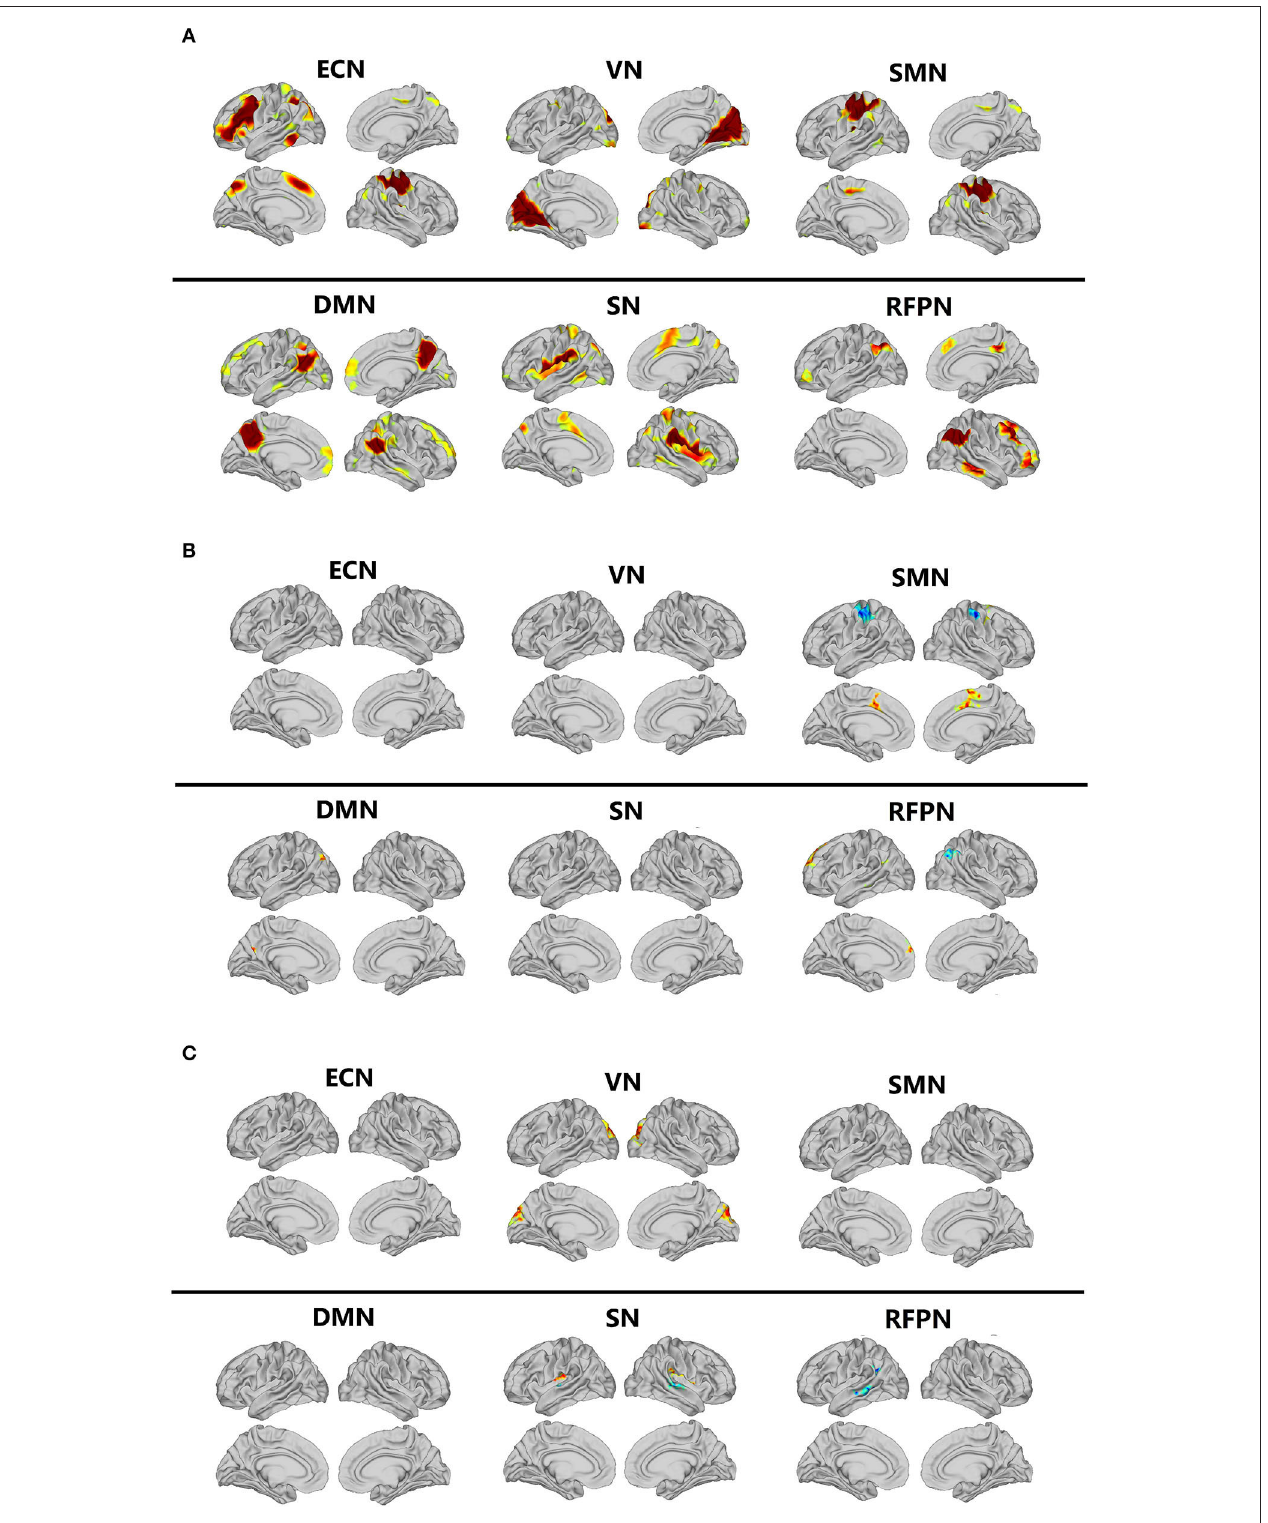
FIGURE 1 | Comparison of resting-state networks. DMN, default mode network; ECN, executive control network; ICA, independent component analysis; RFPN, right frontoparietal network; RSNs, resting-state networks; SMN, sensorimotor network; SN, salience network; VN, visual network. (A) The resting-state networks extracted by ICA. (B) Comparison of condition effect after and before Tai Chi Chuan in all participants. (C) Comparison of interaction effect after and before Tai Chi Chuan in CFS patients and healthy controls.